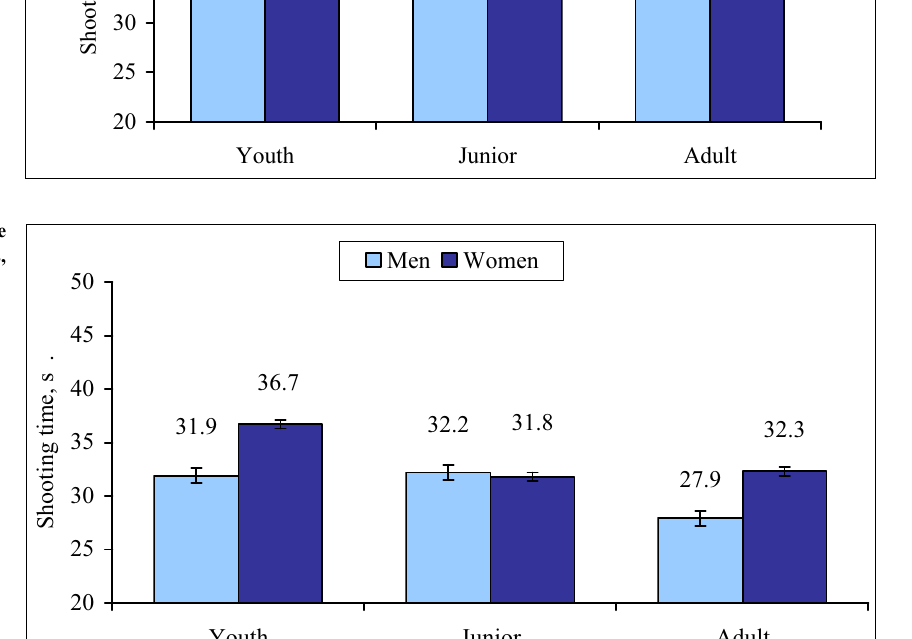
Figure 3. Average shooting time of various age groups, men and women (X ± Sx) Figure 4. Average shooting time of leaders in various age groups, men and women (X ±